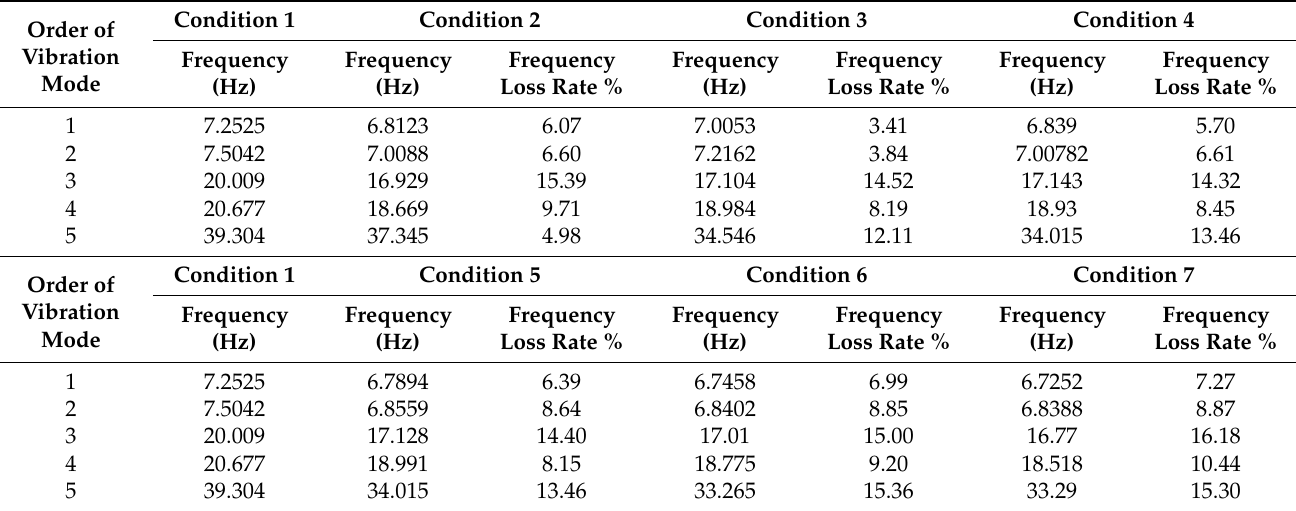
Table 8. Inherent frequency loss rates at different